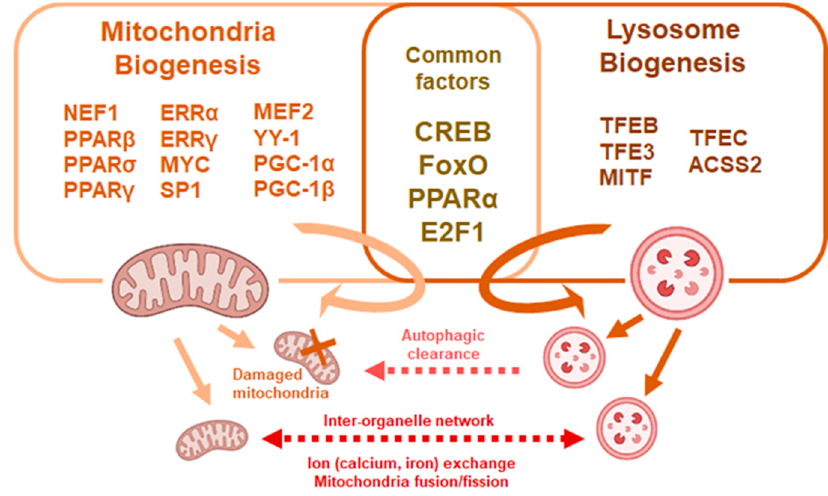
Figure 2. Common factors affect mitochondria and lysosome biogenesis. Mitochondria and lysosomal biogenesis are regulated through multiple factors, some of which are common to both processes. Mitochondria and lysosomes crosstalk though fusion and exchange of metabolites or through autophagic processes.